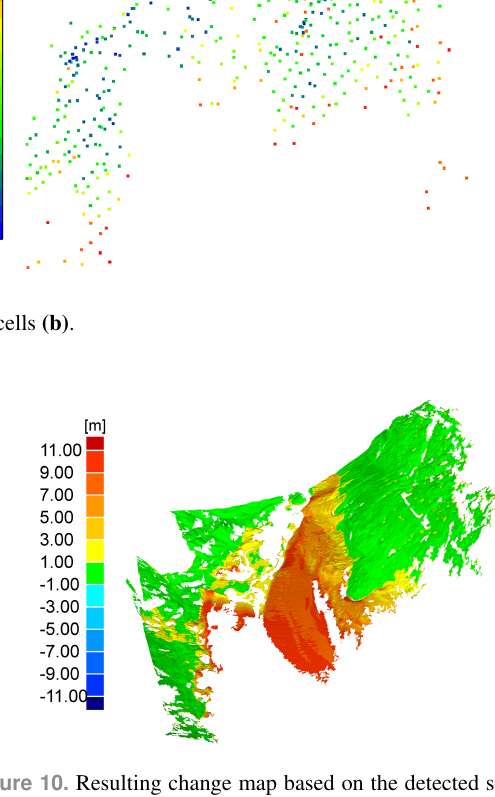
Figure 10. Resulting change map based on the detected stable re-